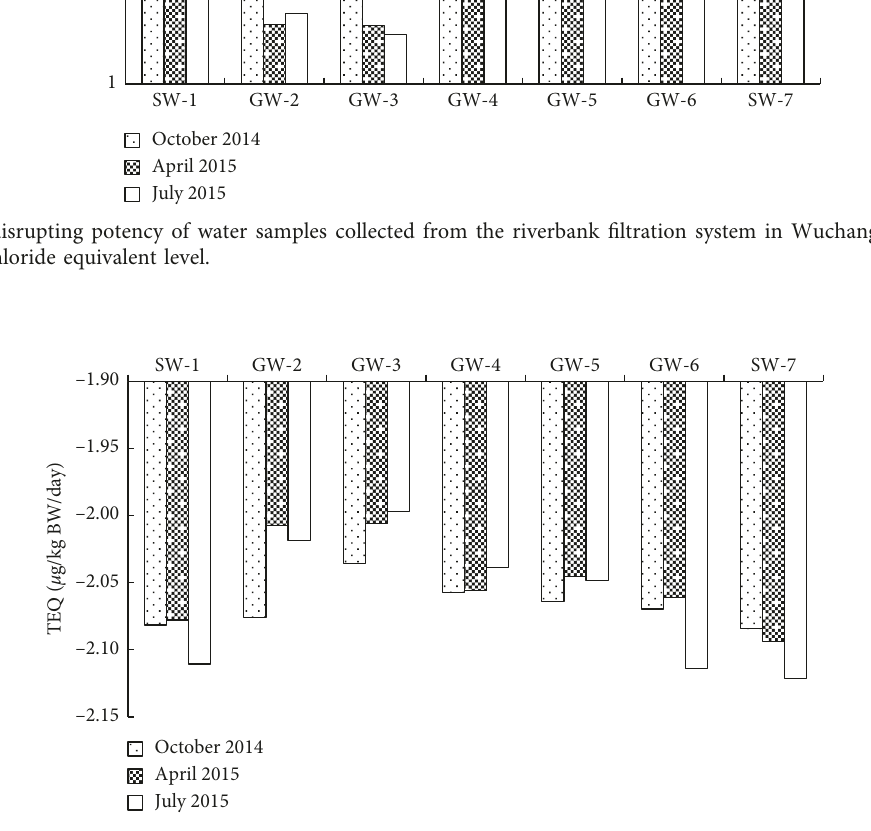
Figure 5: Thyroid-disrupting potency of water samples collected from the riverbank filtration system in Wuchang City, China. TEQ: T3 equivalent activity, BW: body weight. Table 1: Predicted hormonal changes in various groups caused by exposure to the mean level of detected thyroidal antagonist activity in river water and groundwater samples ( μ